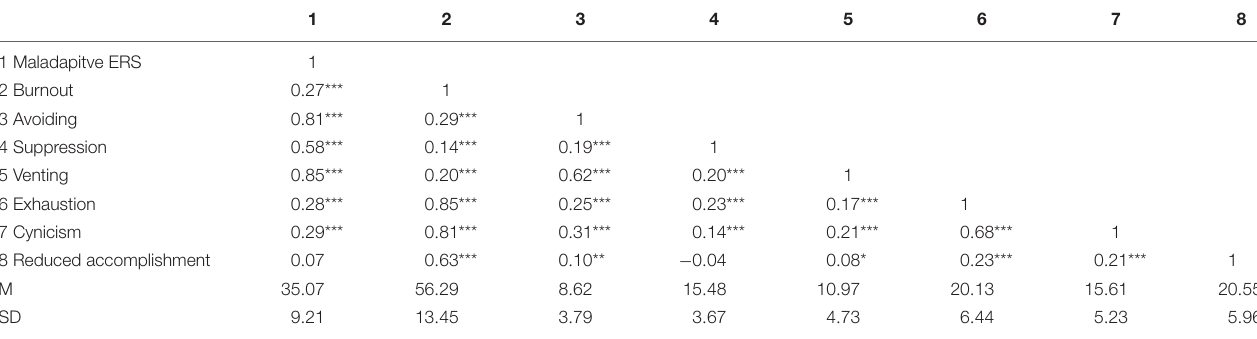
TABLE 2 | Correlations, means and standard deviations of maladaptive emotion regulation strategies (ERS), burnout and subscales of them. 1 2